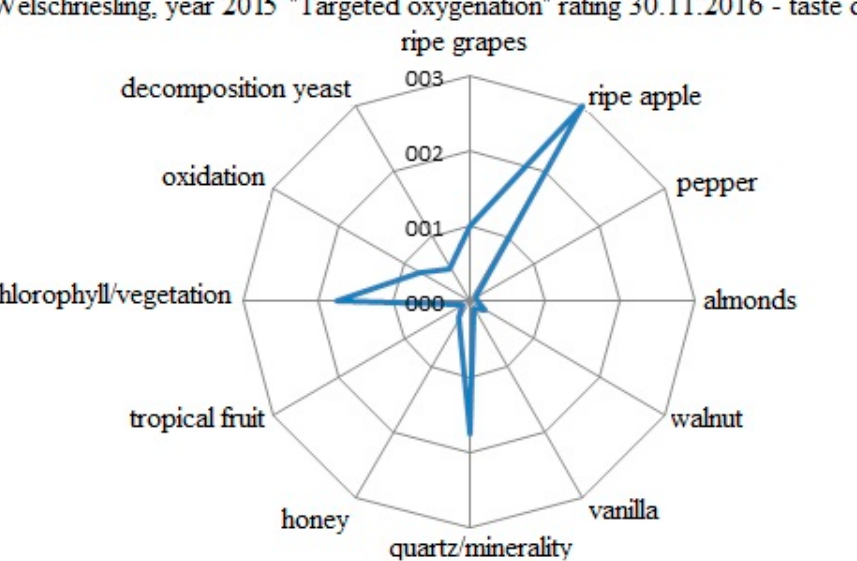
Figure 5 . Evaluation of the specific taste descriptors for the W 2015 variant processed by targeted oxygenation.